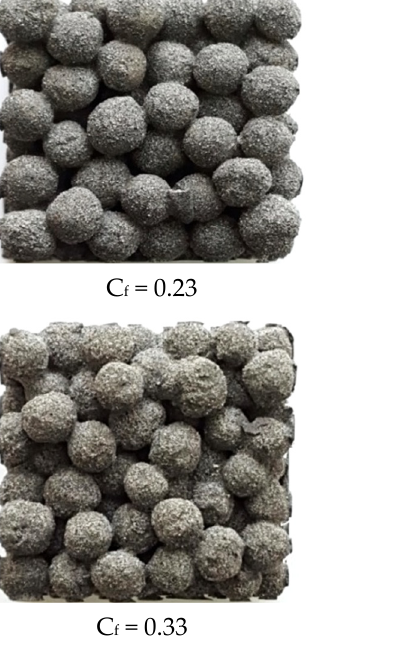
Figure 12. The structure of liquid glass composite materials with different ratio “binder volume: filler volume”.